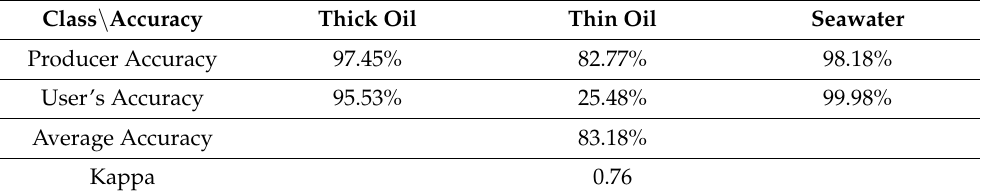
Figure 11. Results of the Random Forest classifier and importance ordering of polarimetric features in study area 1 : ( a ) oil spill detection results; ( b ) variable importance ordering. Table 4. Classification accuracies of the Random Forest classifier in study area 1.